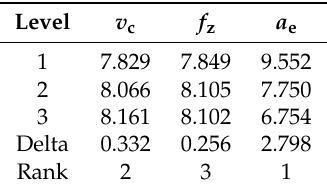
Table 13. Average S/N ratios for ball end milled vertical